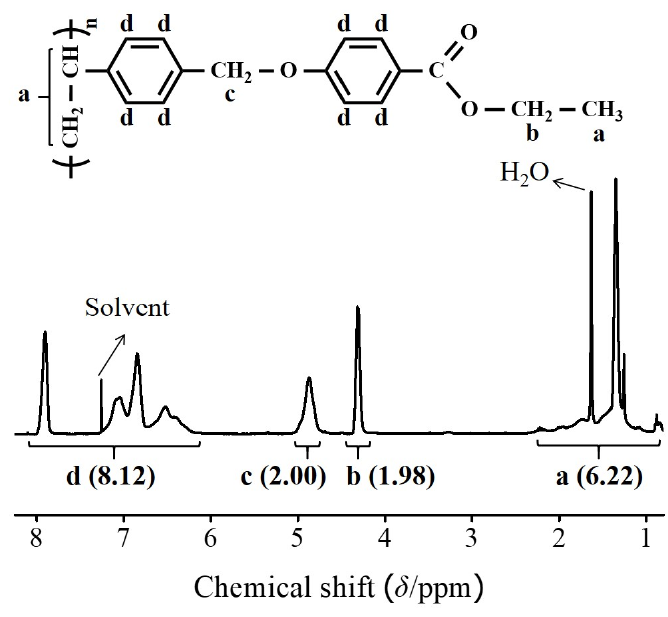
Figure 2. 1 H nuclear magnetic resonance (NMR) spectrum of P2BO.